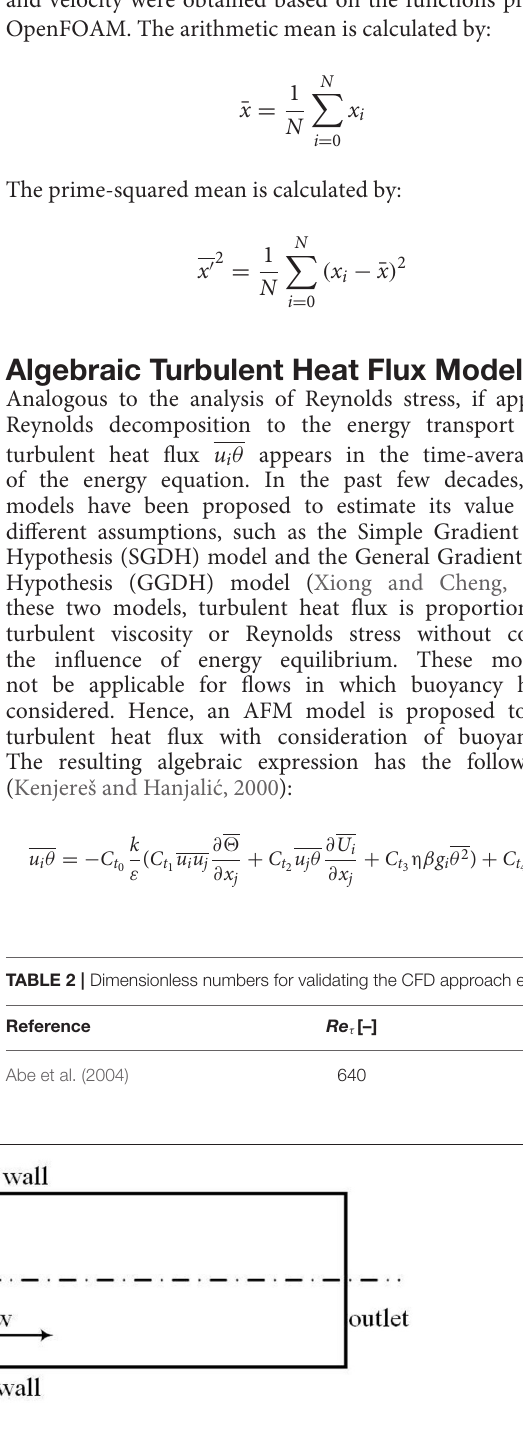
FIGURE 1 | Schematic diagram of the simulation